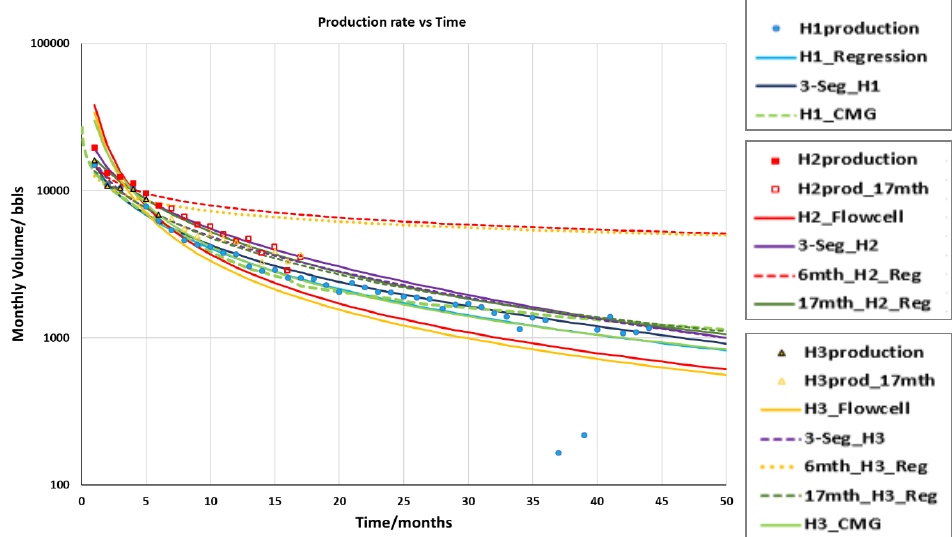
Figure 9. Enhanced view of short-term production rate forecasts for Wells H1, H2, and H3 monthly production data with forecasts from (1) Arps regressions (using both 6 months and 17 months production data), (2) analytical flow-cell model, (3) 3-segment Decline Curve, and (4) CMG model (for Wells H1 and H3 only).